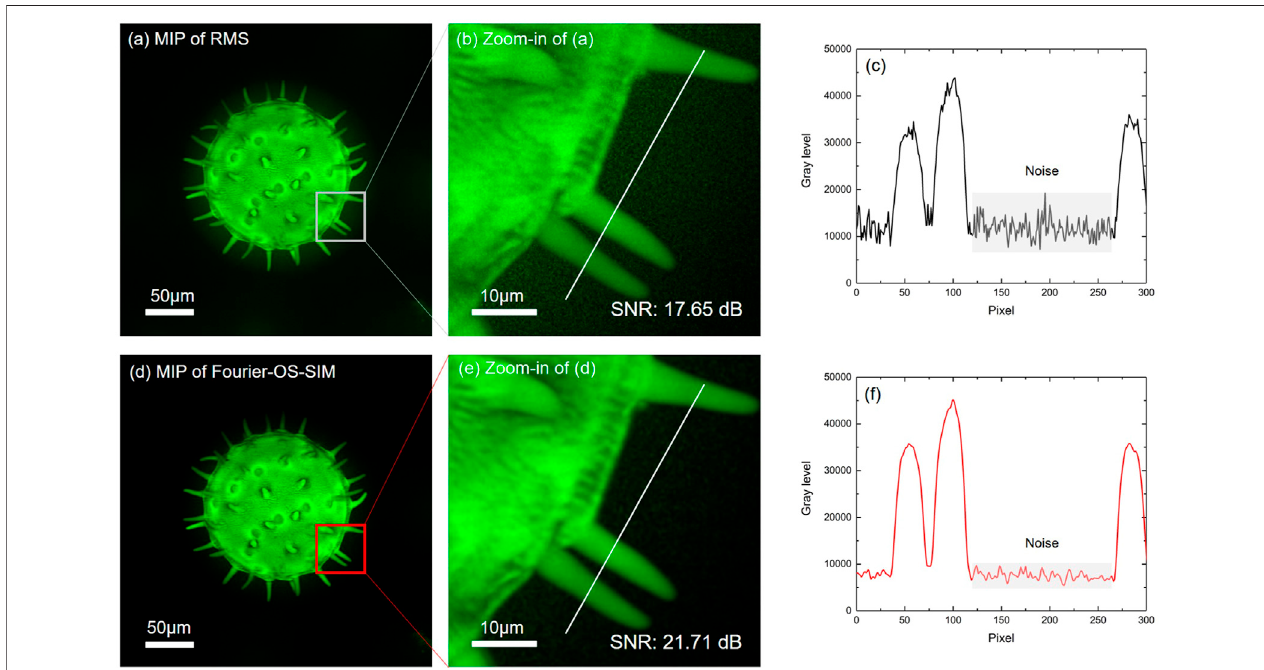
FIGURE4| TheMIPsof3DimagesfromtheFourier-OS-SIMandtheRMSsectionedslicestacks. (A,D) :theMIPsoftheRMSandtheFourier-OS-SIMslicestacks visualized by 3D volume rendering, respectively. (B,E) : the zoom-in images of the ROI in RMS and Fourier-OS-SIM 3D images. (C,F) : the intensity pro fi les along the cut- lines in (B,E)